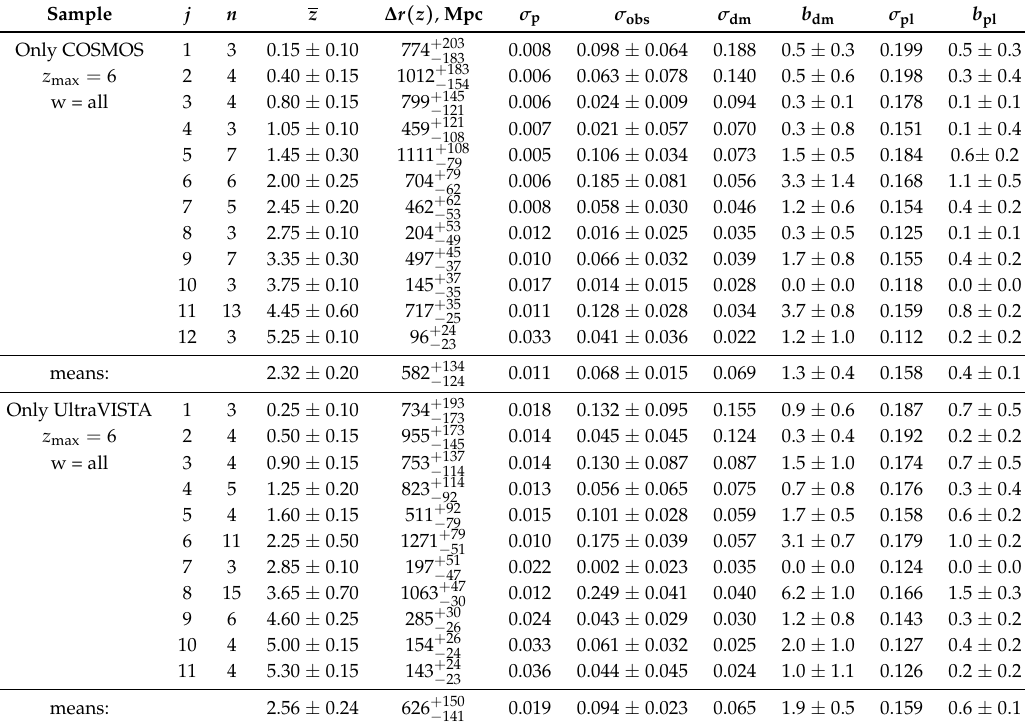
Table A2. Tables of structures for disjoint the COSMOS (top) and UltraVISTA (bottom) samples from the COSMOS2015 catalogue for a bin ∆ z = 0.1 with z max = 6 and without σ z selection. The approximation is by empirical Formula (6). In the last string there are the means of corresponding values (by all structures): mean of redshifts z mean , mean of structure sizes in Mpc R mean , mean of Poisson noise level 1 σ P , mean of observed cosmic variance σ mean , mean of dark matter variance σ dm , mean of dark matter bias b dm , mean of Peebles correlation function variance σ pl and its bias b pl (see details in the